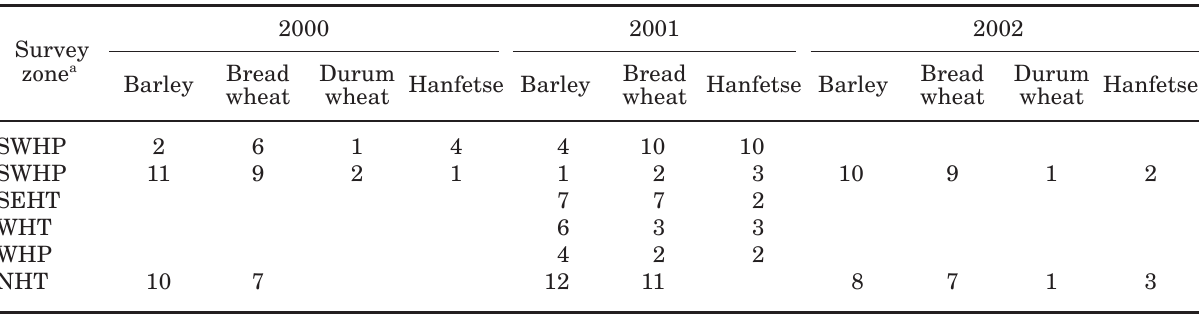
Table 1. Number of fields grown with barley, wheat or hanfetse, in each region in 2000–2002.